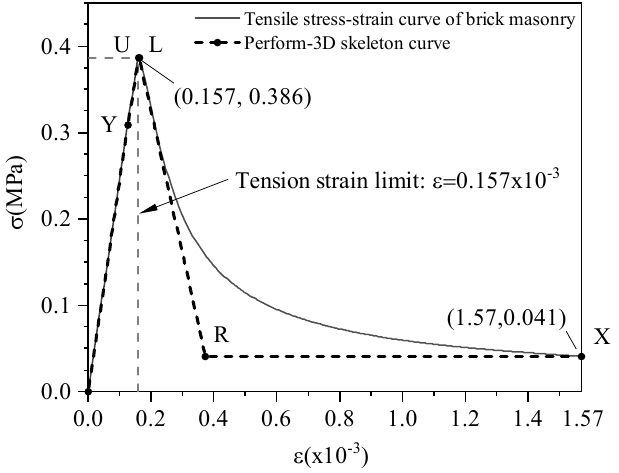
Tensile stress-strain curve of brick masonry Perform-3D skeleton curve